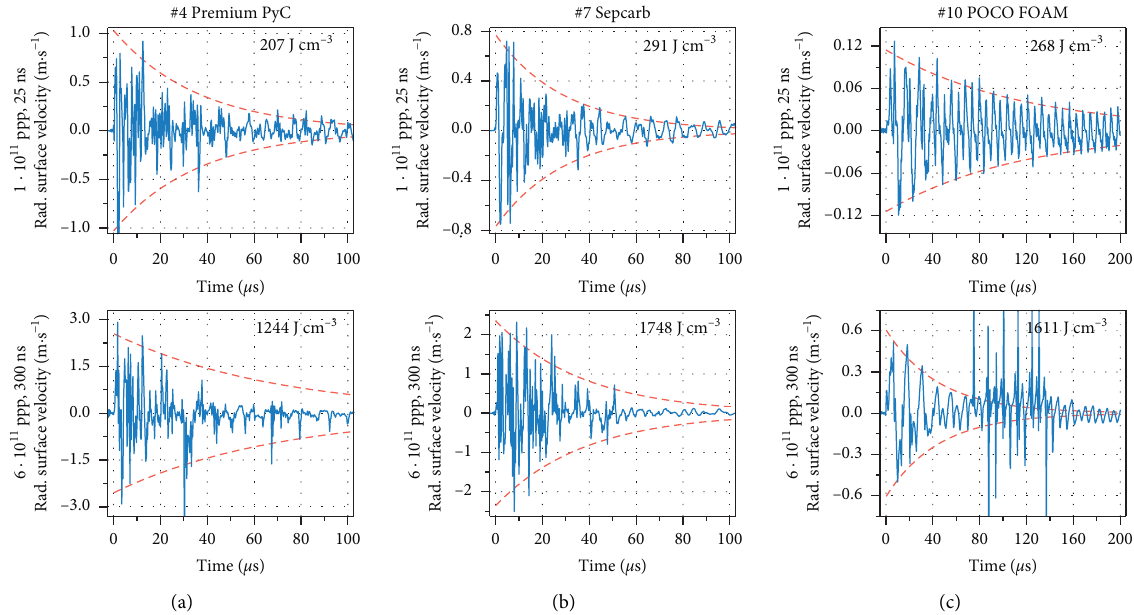
Figure 14: Recorded radial surface velocity (solid blue line) and calculated damping envelope (red dashed line) as a function of time for 100 and 200 μ s after beam impact. (a–c) Compares two different carbon-fiber reinforced graphite composite and graphitic foam: #4 SGL Premium PyC (a), #7 ArianeGroup Sepcarb (b), and #3 POCO FOAM (c) at 1 × 10 11 ppp (top) and 6 × 10 11 ppp (bottom) pulse intensity. The energy density provided in each plot indicates the peak energy deposition in the tantalum core averaged over the length of the sample. The perturbations in (c) are